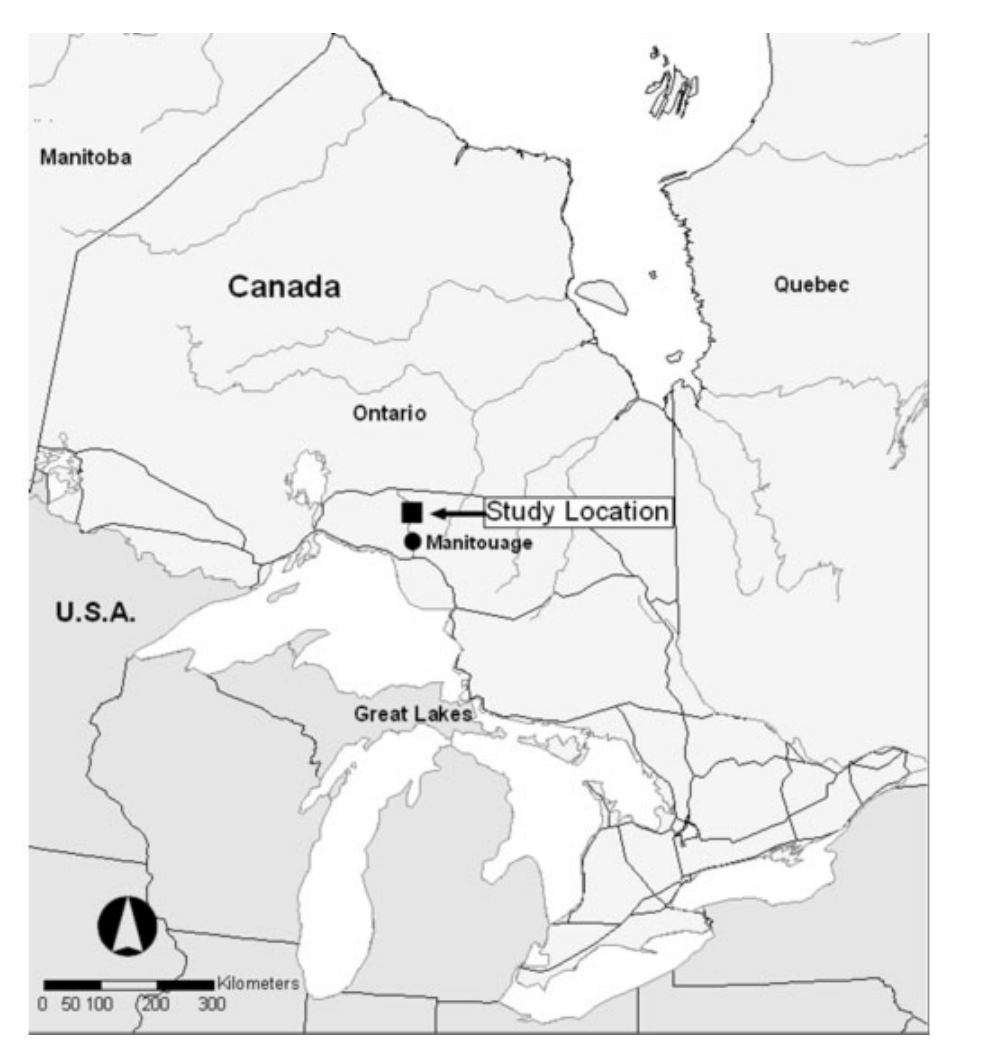
Fig. 1 . Map of the study